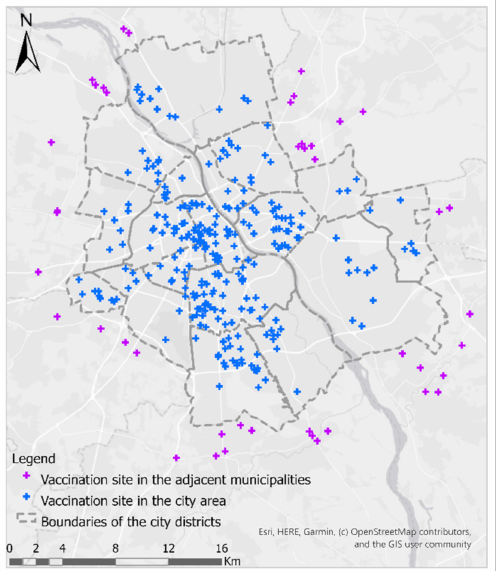
Figure 4. Location of COVID-19 vaccination sites in the area of the Capital City of Warsaw and at a distance of 3 km from its borders.